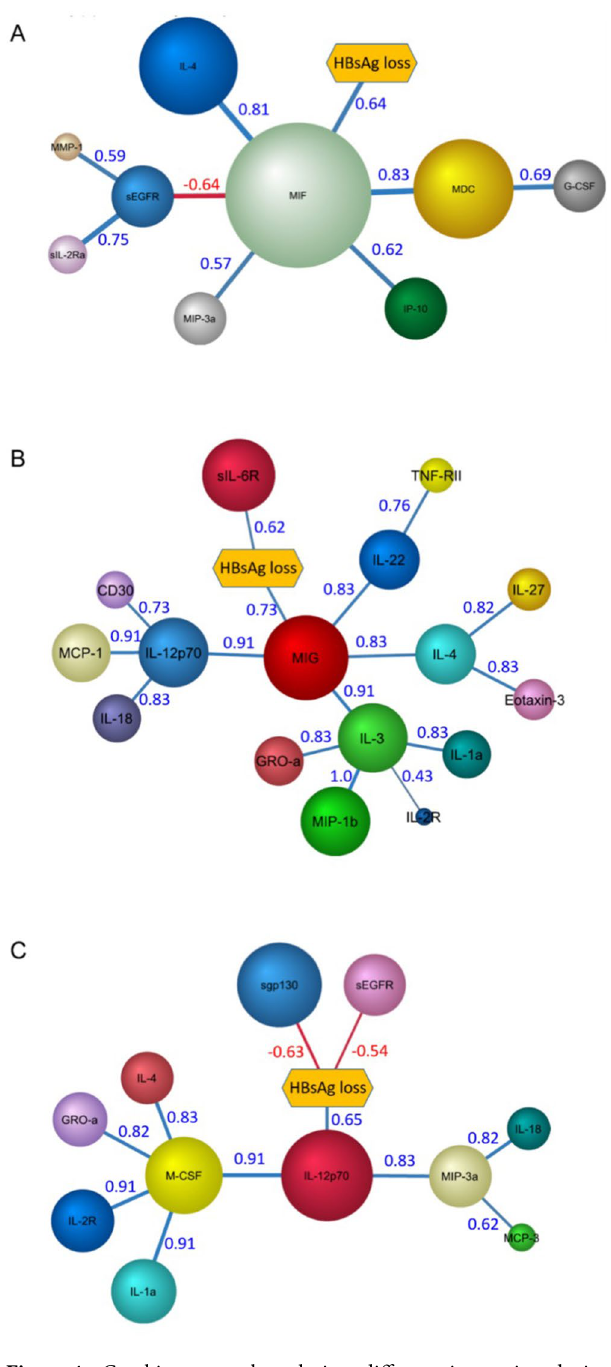
Figure 4. Cytokine network analysis at different time-points during treatment. Bayesian network of cytokines that are associated with responders (patient group) at the baseline time-point ( A ), at the time-point before HBsAg loss ( B ) and after HBsAg loss ( C ). Size of the nodes indicate their relative probabilistic contribution to the loss of HBsAg and the colour of the arcs indicate positive (blue) or negative (red) Pearson correlation between adjoining nodes. The Pearson correlation values for the nodes are as indicated. Network and figures were generated using BayesiaLab software (version 8) (https:// www. bayes ia.